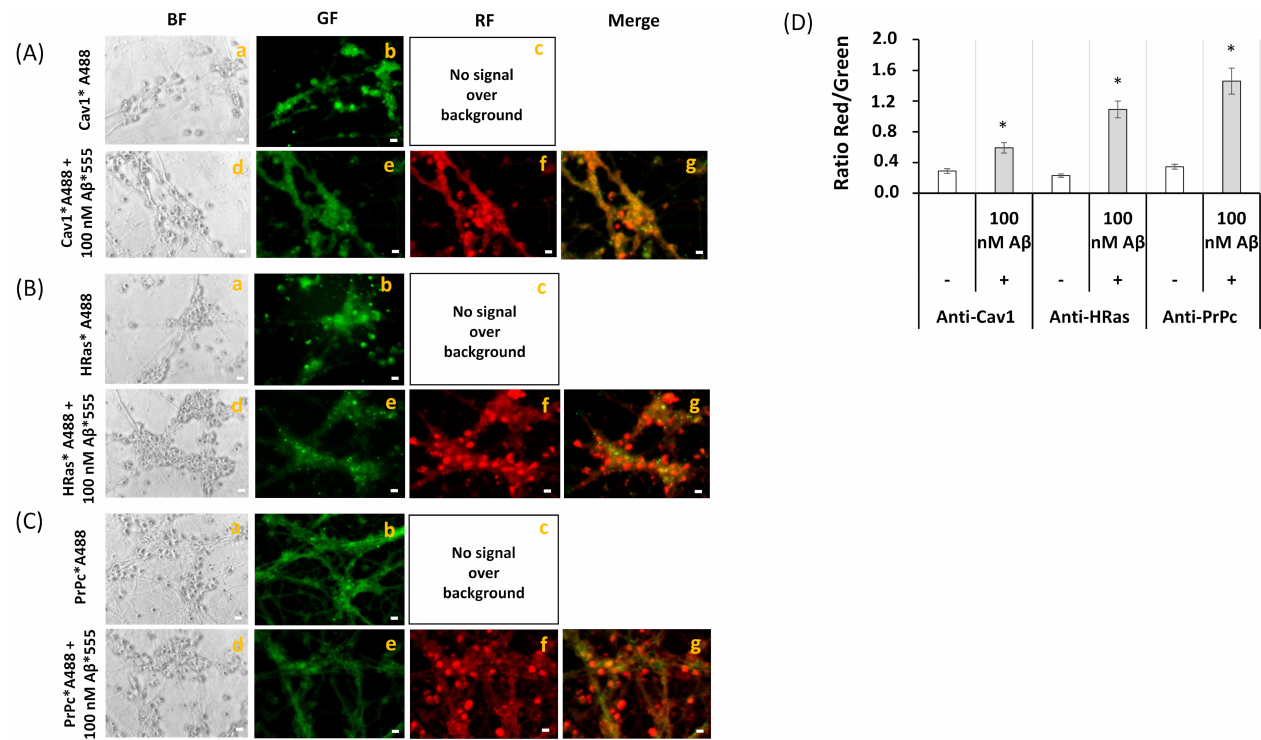
Figure 4. Extensive FRET between the lipid rafts markers Cav1, HRas, PrPc, and A β (1–42). ( A ) Representative quantita- tive fluorescence microscopy images of CGN stained with anti-Cav1 antibody (sc-894)/IgG-Alexa488 (Cav1*A488, a–c) or with anti-Cav1/IgG-Alexa488 and A β (1–42) HiLyte TM -Fluor 555 (Cav1*A488/A β (1–42), d-g). ( B ) Representative quanti- tative fluorescence microscopy images of CGN stained with anti-HRas antibody (sc-32026)/IgG-Alexa488 (HRas*A488, a–c) or with anti-HRas/IgG-Alexa488 and A β (1–42) HiLyte TM -Fluor 555 (HRas*A488/A β (1–42), d-g). ( C ) Representative quantitative fluorescence microscopy images of CGN stained with anti-PrPc antibody (7500997)/IgG-Alexa488 (PrPc*A488, a–c) or with anti-PrPc/IgG-Alexa488 and A β (1–42) HiLyte TM -Fluor 555 (PrPc*A488/A β (1–42), d-g). Bright-field (BF), green fluorescence (GF), and red fluorescence (RF) images are shown for each of the selected fields, and the orange-yellow areas (merge image) point out the higher intensity FRET regions (g, ( A – C )). The exposure time for GF and RF images was 0.4 s. Scale bar inserted in fluorescence microscopy images = 10 µ m. ( D ) Ratio of red/green fluorescence intensity per pixel (RF/GF) obtained from the analysis of fluorescence intensity data of CGN somas stained with (i) anti-Cav1/IgG-Alexa488 only (Cav1*A488) and double stained with anti-Cav1*IgG-Alexa488/A β (1–42) HiLyte TM -Fluor 555 (Cav1*A488/A β (1–42)); (ii) anti-HRas/IgG-Alexa488 only (HRas*A488) and double stained with anti-HRas*IgG-Alexa488/A β (1–42) HiLyte TM -Fluor 555 (HRas*A488/A β (1–42)); and (iii) anti-PrPc/IgG-Alexa488 only (PrPc*A488) and double stained with anti-PrPc*IgG- Alexa488/A β (1–42) HiLyte TM -Fluor 555 (PrPc*A488/A β (1–42)). The results shown in panel D are the mean ± s.e. (*) p < 0.05, (i.e., statistically significant with respect to the control, CGN labeled with the Alexa488 FRET donor only). Representative fluorescence microscopy images of mature CGN stained with anti-CaM conjugated with IgG-Alexa 488 (anti-CaM*A488), anti-HRas conjugated with IgG-Cy3 (anti- HRas*Cy3), and with both anti-CaM*A488 and anti-HRas*Cy3 are shown in Figure 5A.